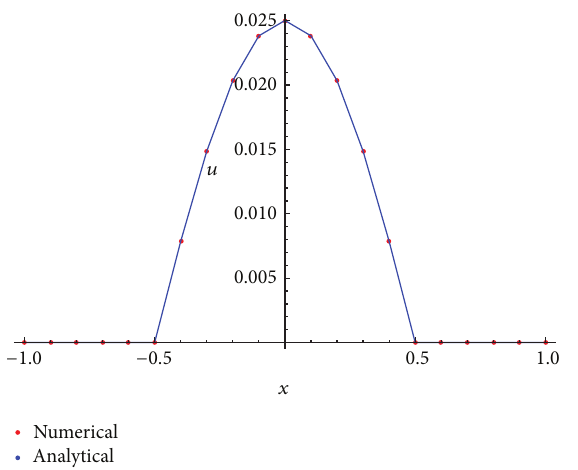
Figure 3: Numerical and analytical solution plot (16 nodes), with constant basis-Problem 1.